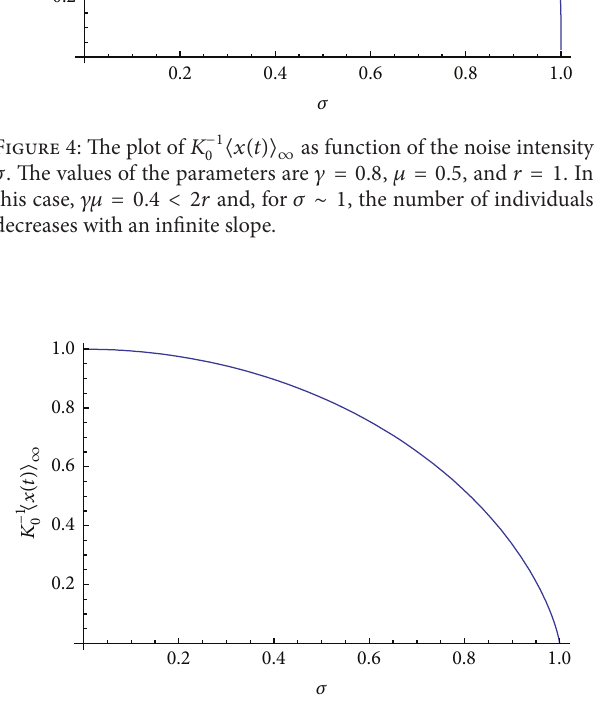
Figure 5: The plot of 𝐾 −1 0 ⟨𝑥(𝑡)⟩ ∞ as function of the noise intensity 𝜎 . The values of the parameters are 𝛾 = 4.8 , 𝜇 = 0.5 , and 𝑟 = 1 . In this case, 𝛾𝜇 = 2.4 > 2𝑟 and, for 𝜎 ∼ 1 , the number of individuals decreases with a finite